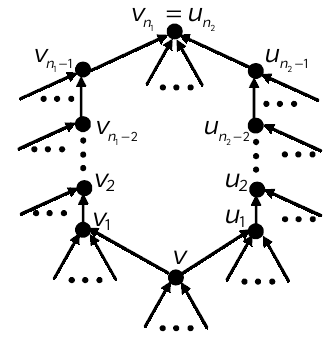
Fig 11. Optimal hierarchy reconstruction with group-monotonic cost